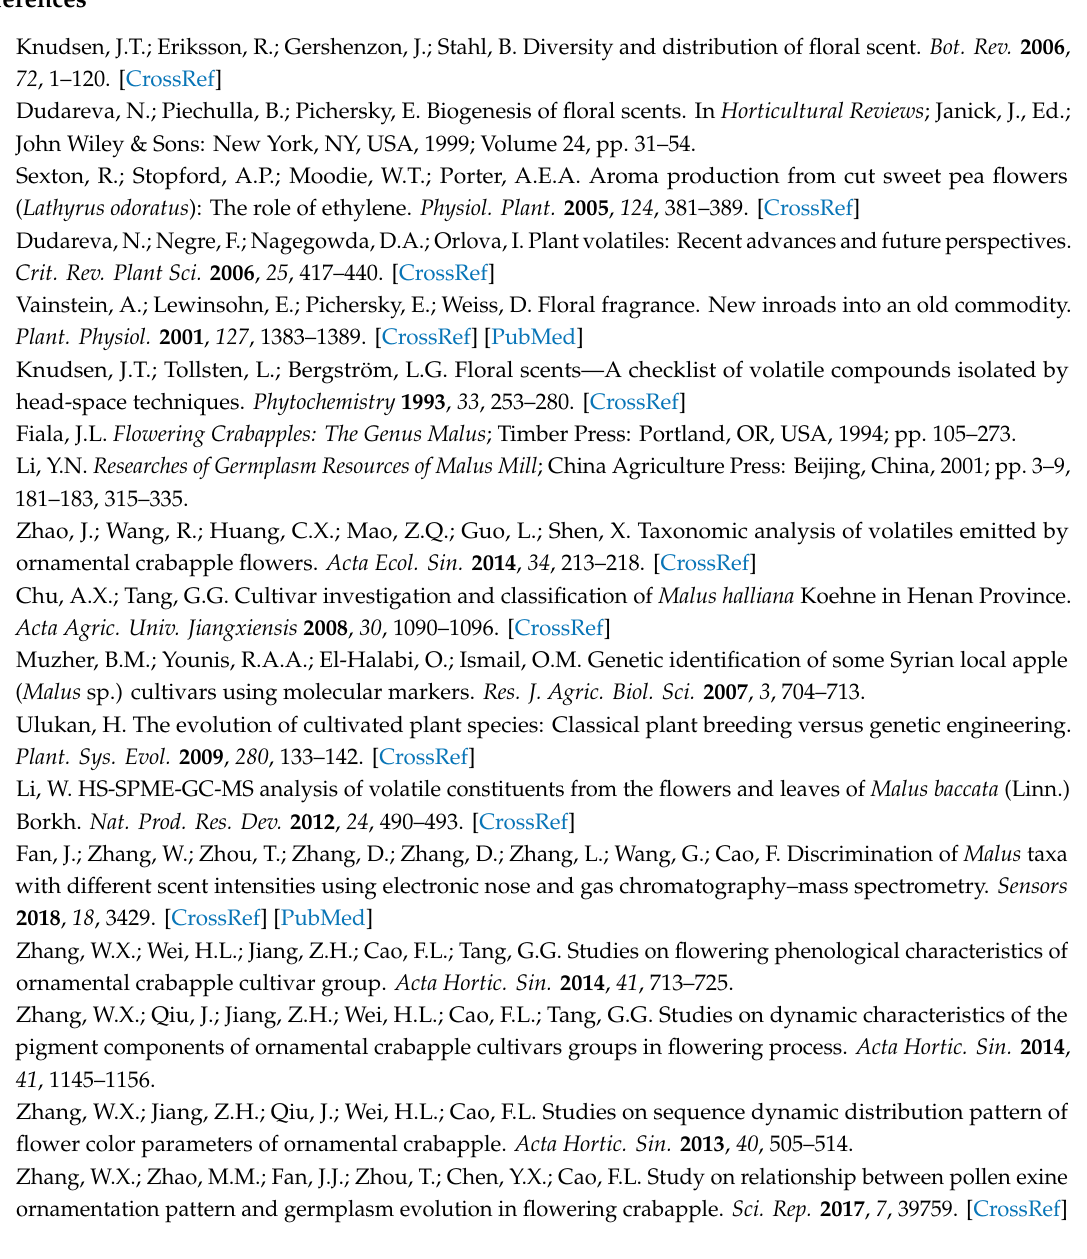
Supplementary Materials: The following are available online. Figure S1: Total ionic chromatogram of volatile compounds emitted from flowers of M. ioensis ‘Prairie Rose’ in di ff erent stages. S1 bud stage; S2 initial flowering stage; S3 flowering stage; and S4 end of flowering stage, Figure S2: Total ionic chromatogram of volatile compounds emitted from M. ioensis ‘Prairie Rose’ flowers during the day and night. N1 1:00–3:00, D2 6:00–8:00, D3